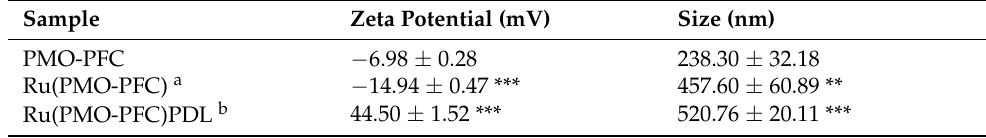
Table 1. Zeta potential (mean value ± standard deviation) and size measurement (mean value ± standard deviation) of particles. ANOVA: p < 0.01 (**), p < 0.001 (***) and a = significant difference between PMO-PFC and Ru(PMO-PFC), b = significant difference between Ru(PMO-PFC) and Ru(PMO-PFC)PDL. Number of repeated experiments (N) = 3.